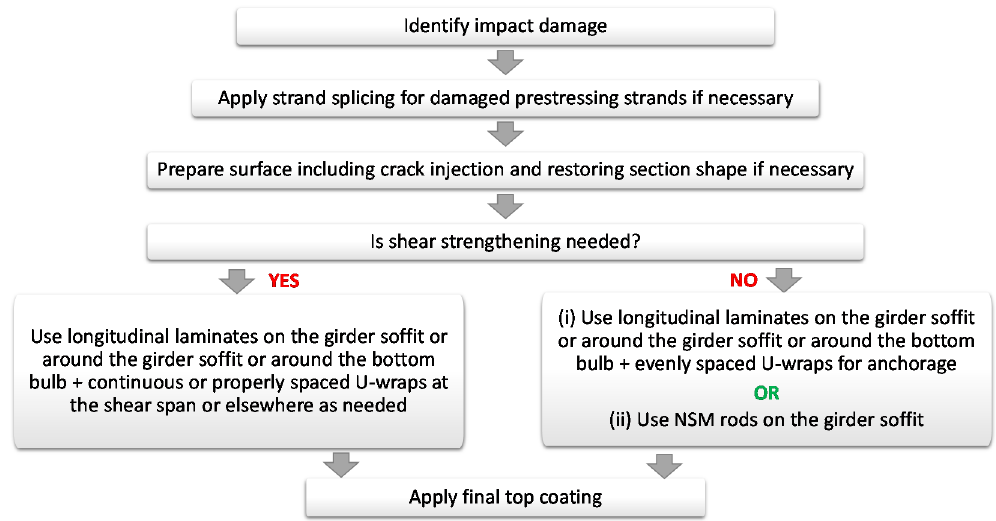
Figure 24. Recommended repair procedure for RC bridge girders with impact or flexure damage.